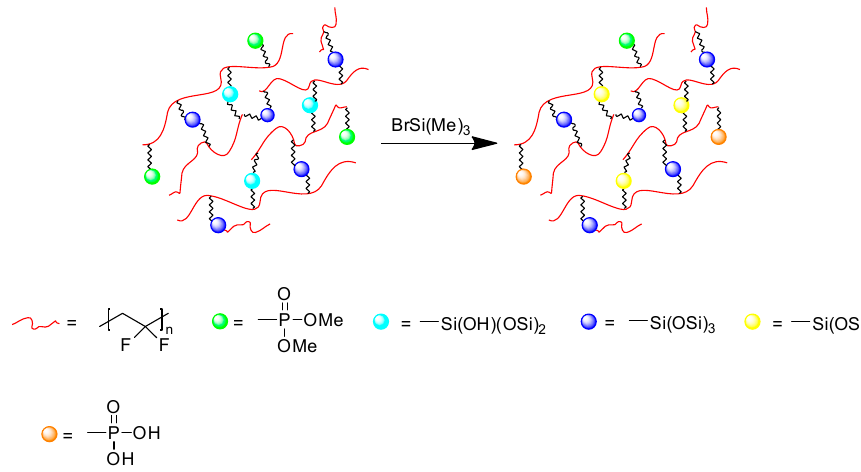
Figure 8. Sketch of silanols’ chemical change in crosslinked poly(VDF- ter -VPA- ter -VTEOS) terpolymer ( CP 20 ) by Me 3 SiBr to lead to hydrolyzed crosslinked polymer ( HCP 20 ).